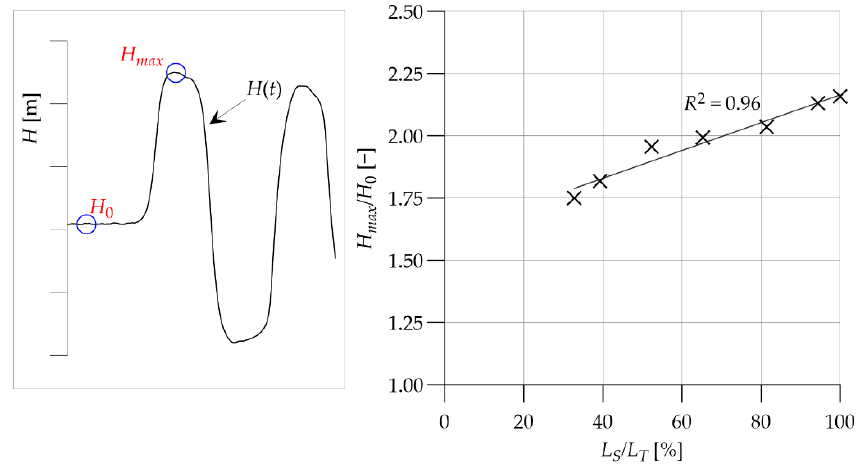
Figure 5. Values of dimensionless maximum pressure increase as a function of L S / L T .